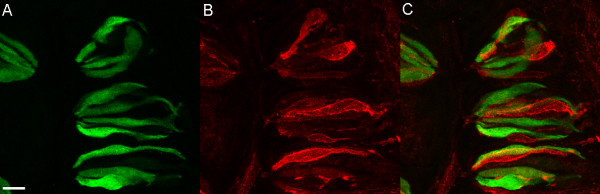
Z-series stack of five LCSMs 0.5 μm apart from mouse circumvallate papillae showing TRPM5 promoter driven GFP expression and SNAP-25-LIR. Green denotes GFP expression (A, C) and red SNAP-25-LIR (B, C). The GFP+ cells appear to be a separate population than those with SNAP-25-LIR. Scale bar is 20 μm.